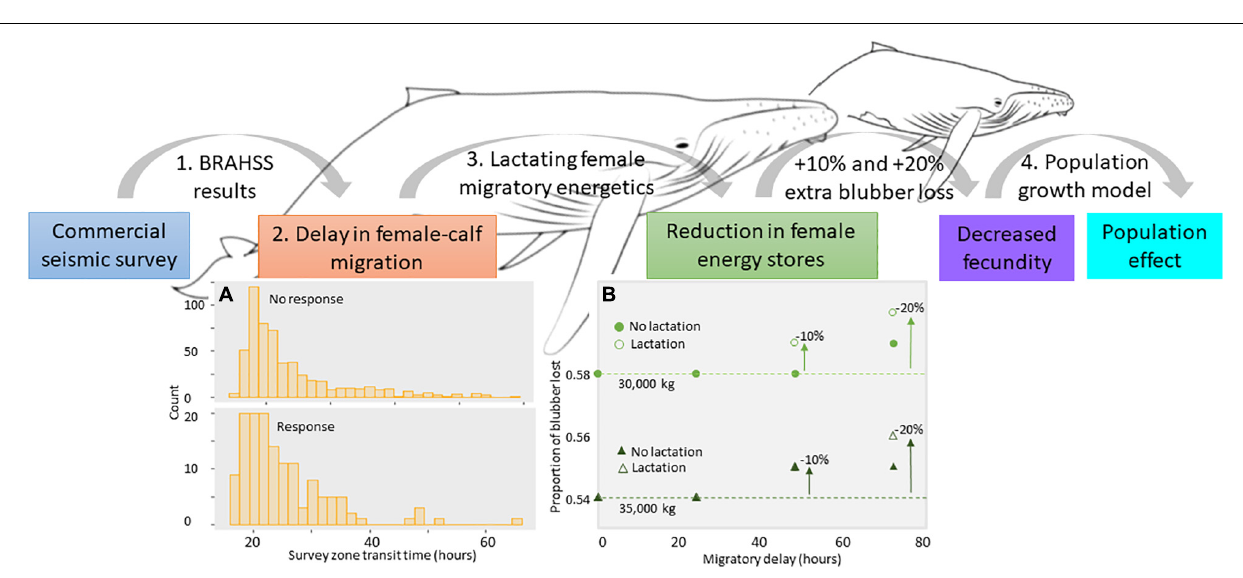
FIGURE 2 | Overview of the forwards (top) PCoD approach. The model starts with the sound source (commercial seismic air gun sound), where the results of the BRAHSS experiments were used within an ABM, where parameterized agents migrated through a commercial seismic survey. The behavioral response was quantified as a delay in migration of humpback whale groups due to a change in the migratory movement (A) . We concentrated on female-calf pairs (lactating females) and assumed a migratory delay would cause a deterioration in lactating female energy stores, quantified as an increase in the proportion of blubber lost over the whole migration (B) . If severe, this would prevent them from becoming pregnant in the following breeding cycle, meaning a reduction in the population’s fecundity and growth rate. (A) Results of the ABM showing distribution of the number of hours that lactating female-calf pairs agents spent within the seismic survey zone for those that were primarily migrating. Distributions are separated into agents that responded and agents that didn’t respond to the seismic air gun array. (B) Results of the energetic model showing the change in the total proportion of blubber lost by a 30,000 and 35,000 kg female during its migration according to how many hours it was delayed within the seismic survey zone and whether or not the female continued to nurse while delayed. Dotted lines indicate no change. The 10 and 20% extra blubber loss thresholds are also